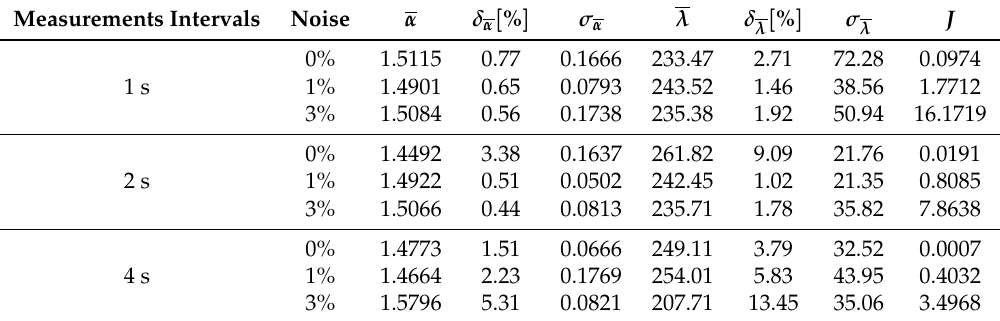
Table 2. Results of calculations in the case of two measurement points ( α i —reconstructed value of order derivative, λ i —reconstructed value of diffusion coefficient, δ —the relative error of reconstruction, σ —standard deviation, J —the value of